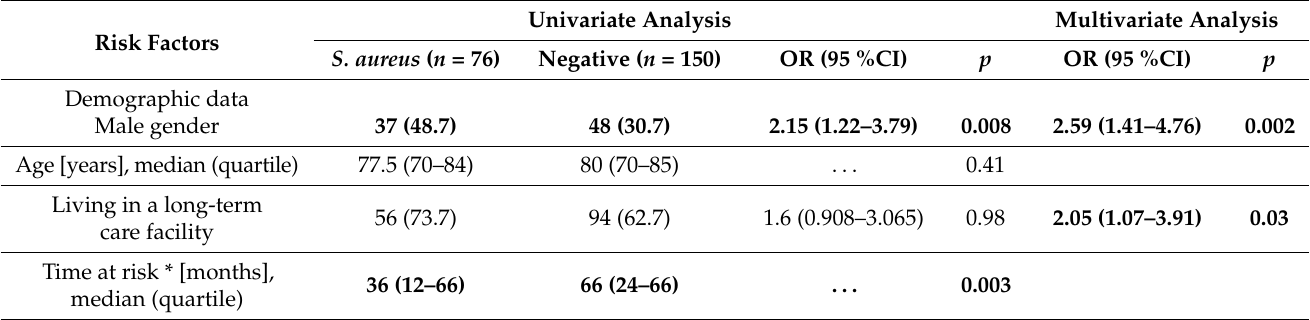
Table 3. Univariate and multivariate analysis (logistic regression model) of predictors of S. aureus